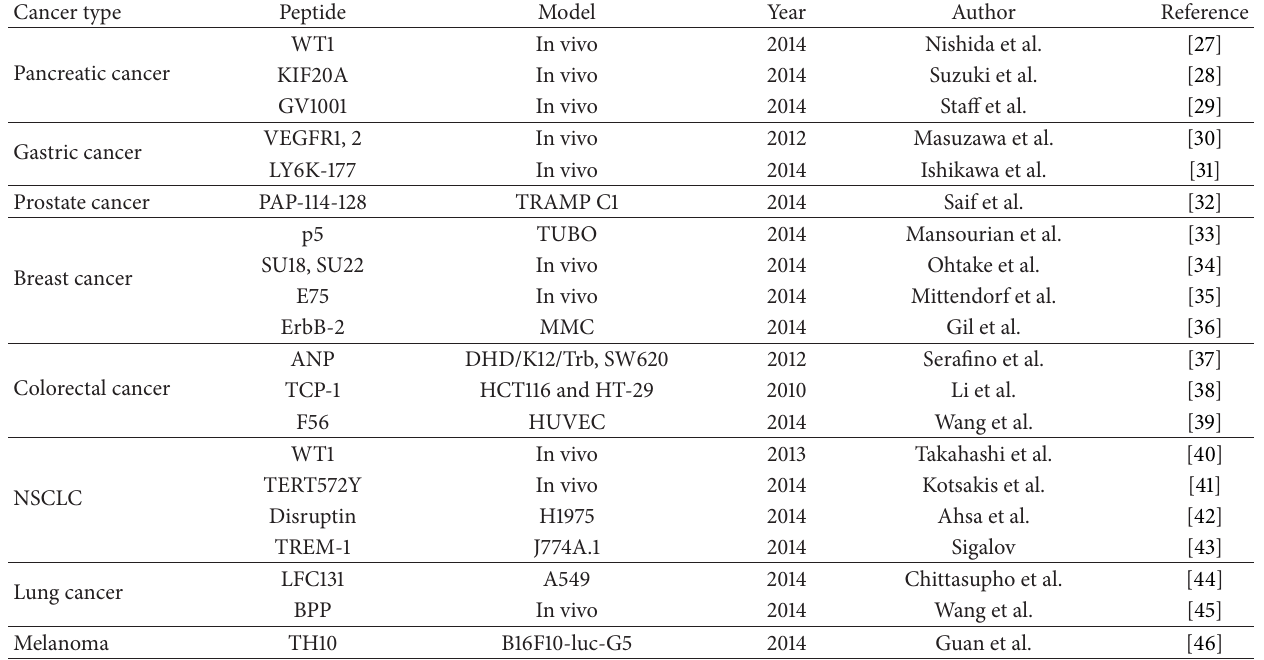
Table 2: Peptides applied in treating